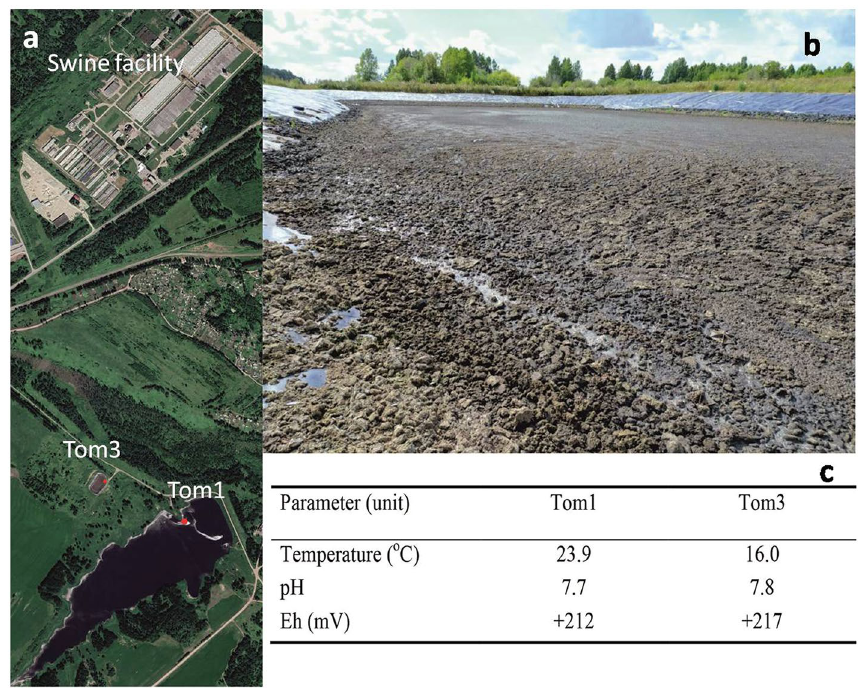
Figure 1. Google image of swine facility, manure storage lagoon, and solid–liquid separation lagoon with sampling locations ( a ), manure lagoon ( b ), and characteristics of the sites at the time of sampling ( c ). Maps Data: Google, CNES/Airbus, Landsat/Copernicus, Maxar Technologies,